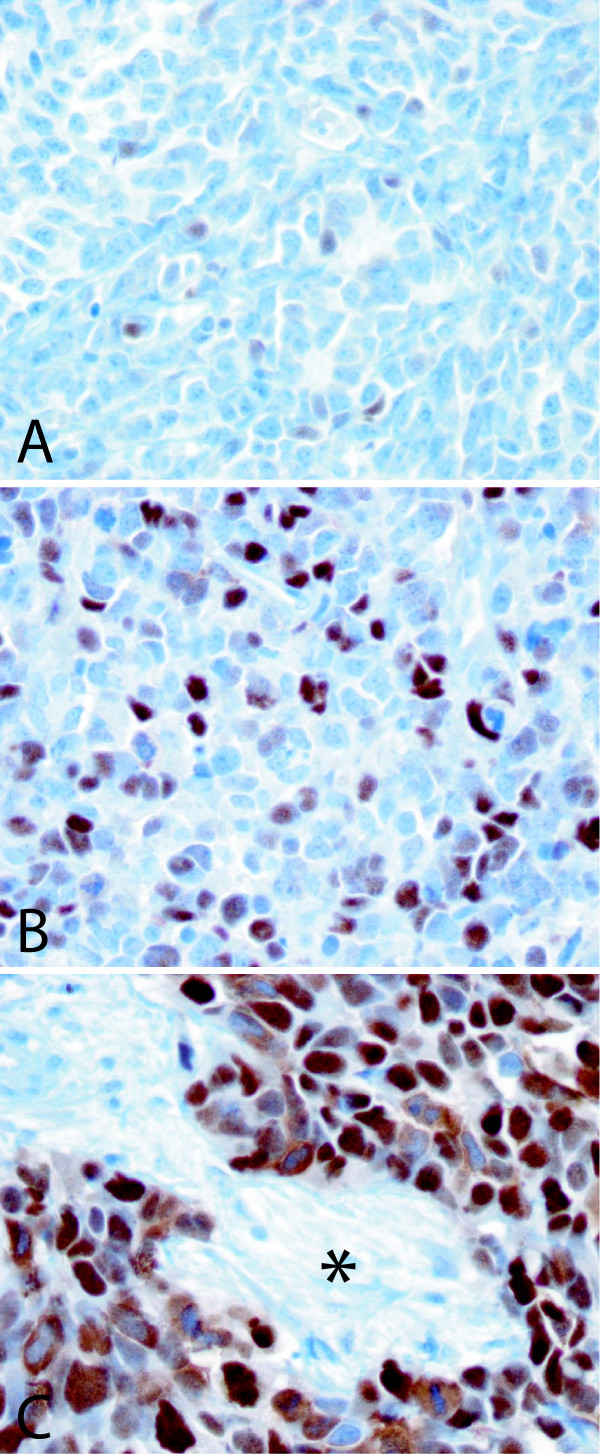
p53 Immunostaining in CNS embryonal tumors. Most p53 immunopositivity was relatively faint and present only in a small fraction of the tumor. This nodular medulloblastoma had weak staining in less than 25% of cells (A). Some anaplastic medulloblastomas had strong p53 immunostaining in a larger fraction of cells (B). Most AT/RT and supratentorial PNET contained p53 immunopositive cells, like this lesion metastatic within the CNS in which almost all cells are strongly positive (C). Note the lack pf staining in non-neoplastic stroma (Asterisk).